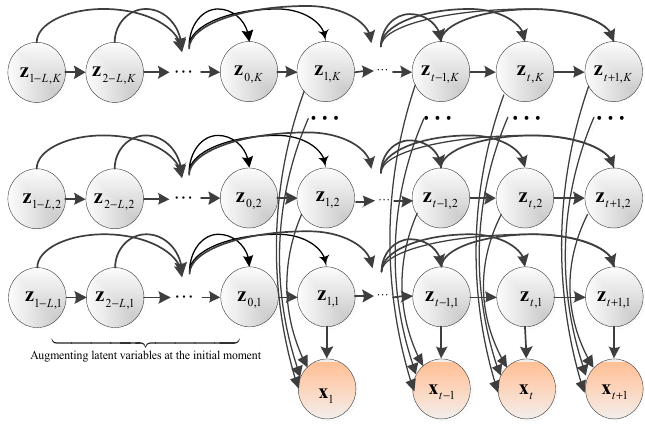
Figure 3. Topology of FDALM.